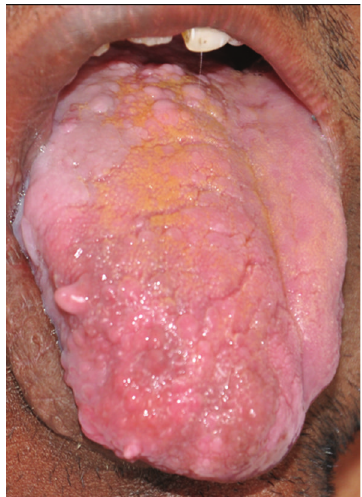
Figure 3: Intraoral photograph showing enlargement of right side of the tongue with enlarged